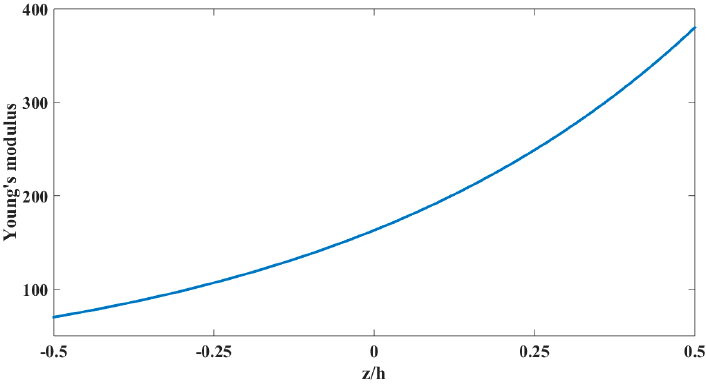
Figure 2. Variation of the Young’s modulus (G.Pa) of the E-FGM beam.